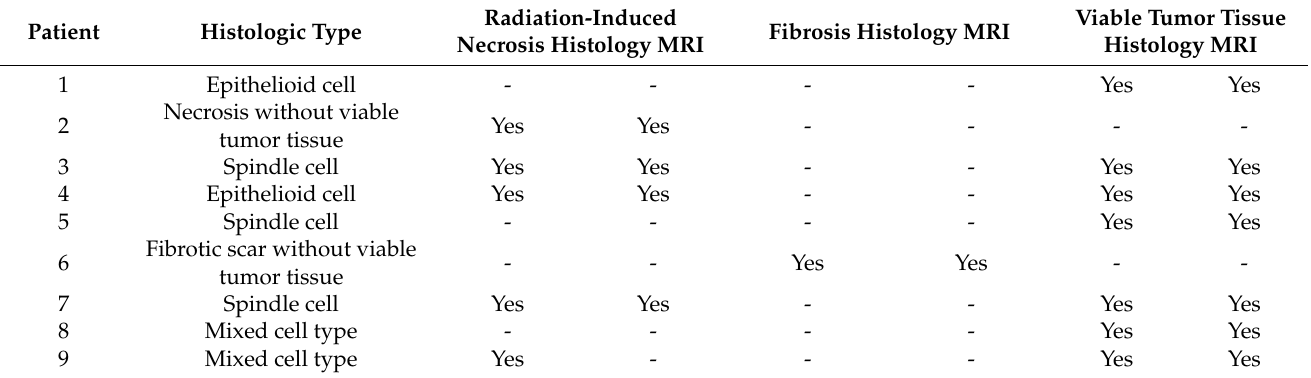
Table 3. Histopathologic and MRI findings with respect to irradiated and subsequently enucleated tumors.